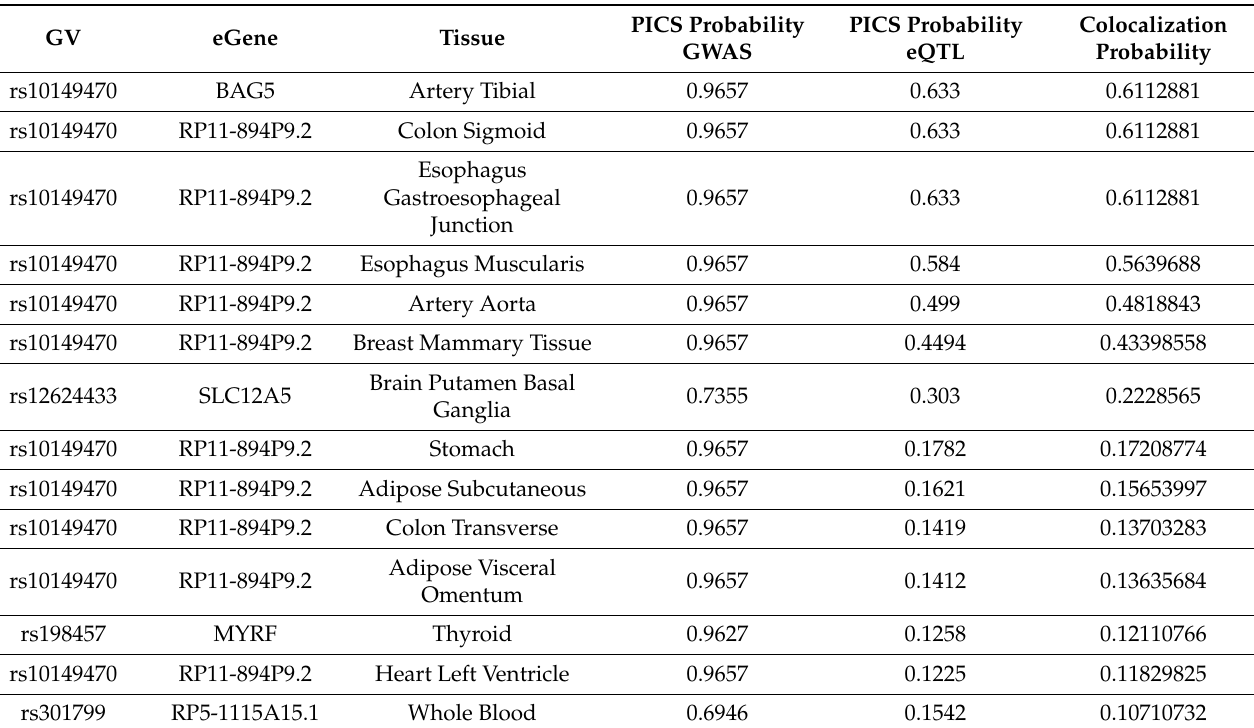
Table 1. GWAS-eQTL Colocalizing GVs in MD. MD associated GVs colocalizing with